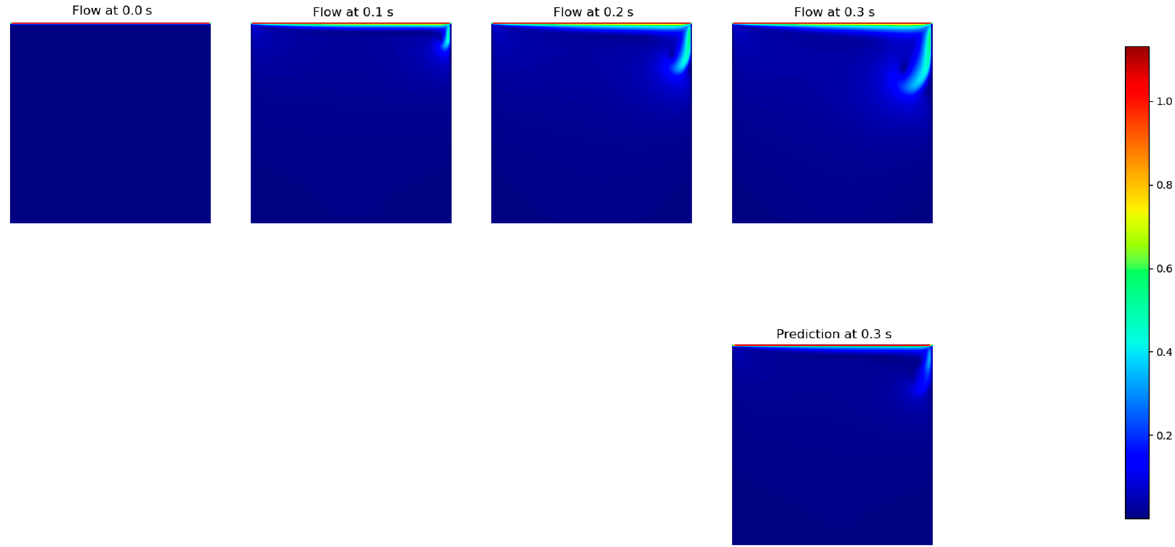
Figure 4. Flow velocities obtained by the ConvLSTM model after tuning, for t = 0.3 s.